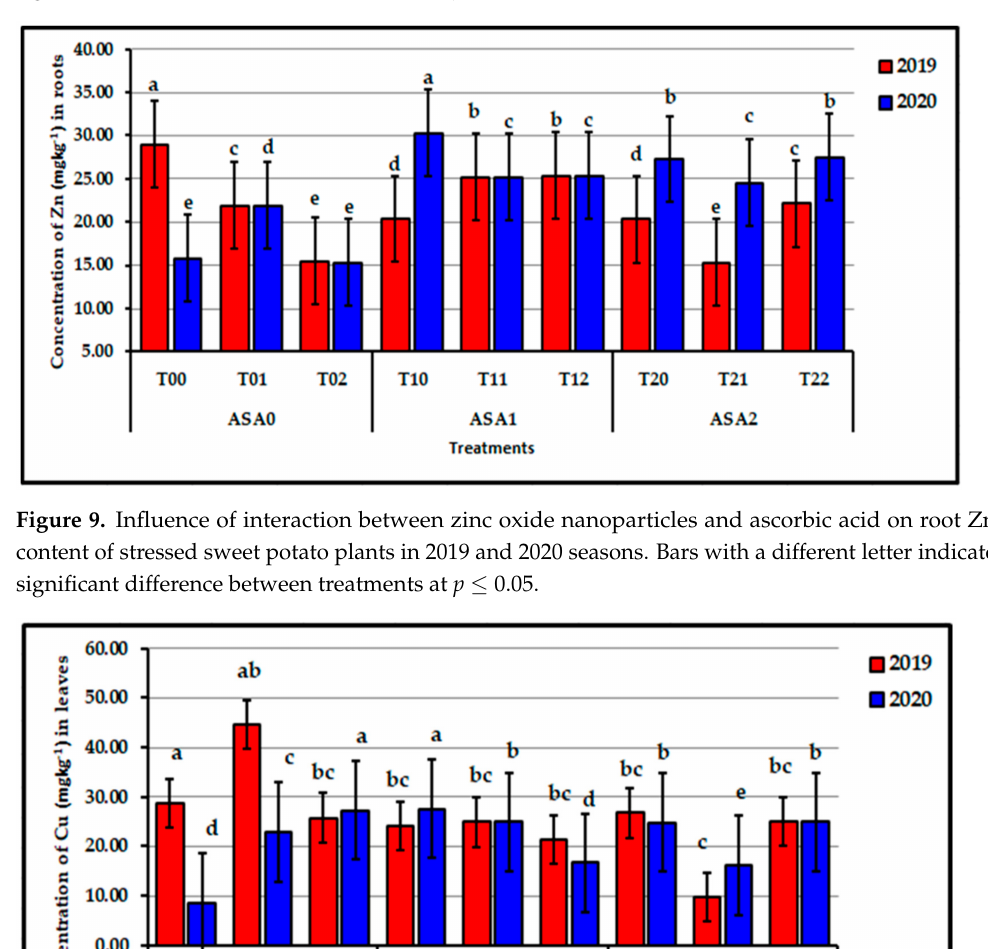
Figure 8. Influence of interaction between zinc oxide nanoparticles and ascorbic acid on leaf Zn content of stressed sweet potato plants in 2019 and 2020 seasons. Bars with a different letter indicate significant difference between treatments at p ≤ 0.05.